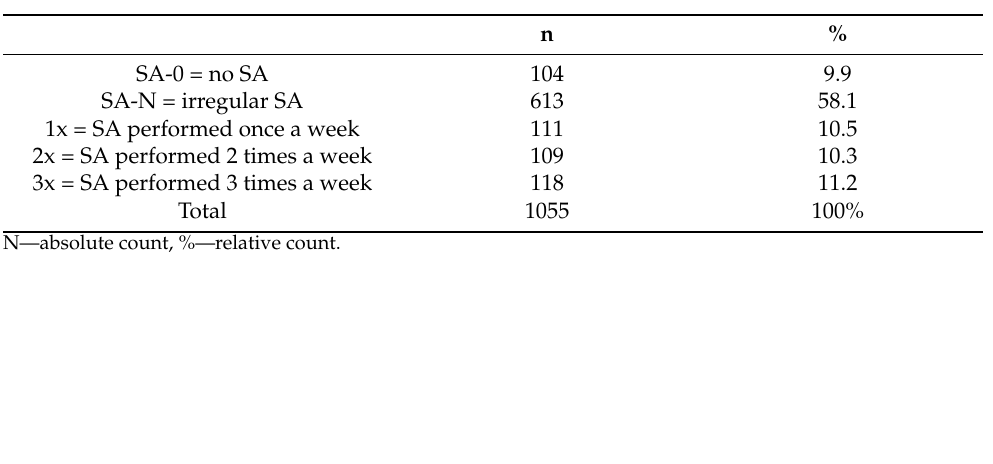
Table 3. SA of university students in the last six